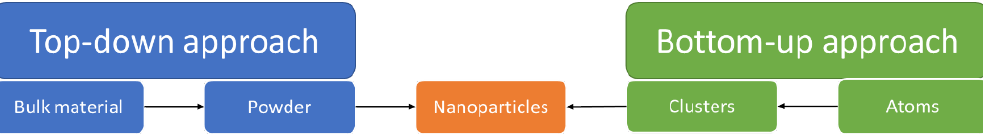
Figure 1. Nanoparticles synthesis approaches. Adapted from an open-access source [40].